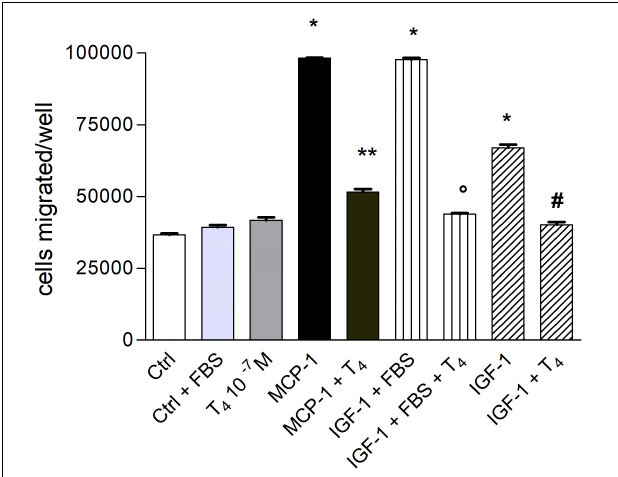
FIGURE 1 | Effect of T 4 (10 − 7 M) on the migration induced by monocyte chemoattractant protein 1 (MCP-1; 100 ng/ml) and insulin-like growth factor-1 (IGF-1; 10 − 8 M) with or without fetal bovine serum (FBS) 0.2%. Results are reported as mean ± SD of n = 3 different experiments carried out in duplicate. * p < 0.0001 vs. all others; ** p < 0.001 vs. MCP-1; ◦ p < 0.0001 vs. IGF-1 (0.2% FBS); # p < 0.0001 vs. IGF-1.